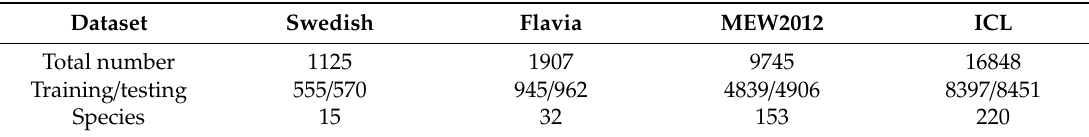
Table 2. In the following, all tests were repeated 10 times to get a convincing result. Table 2. Detail information of the four